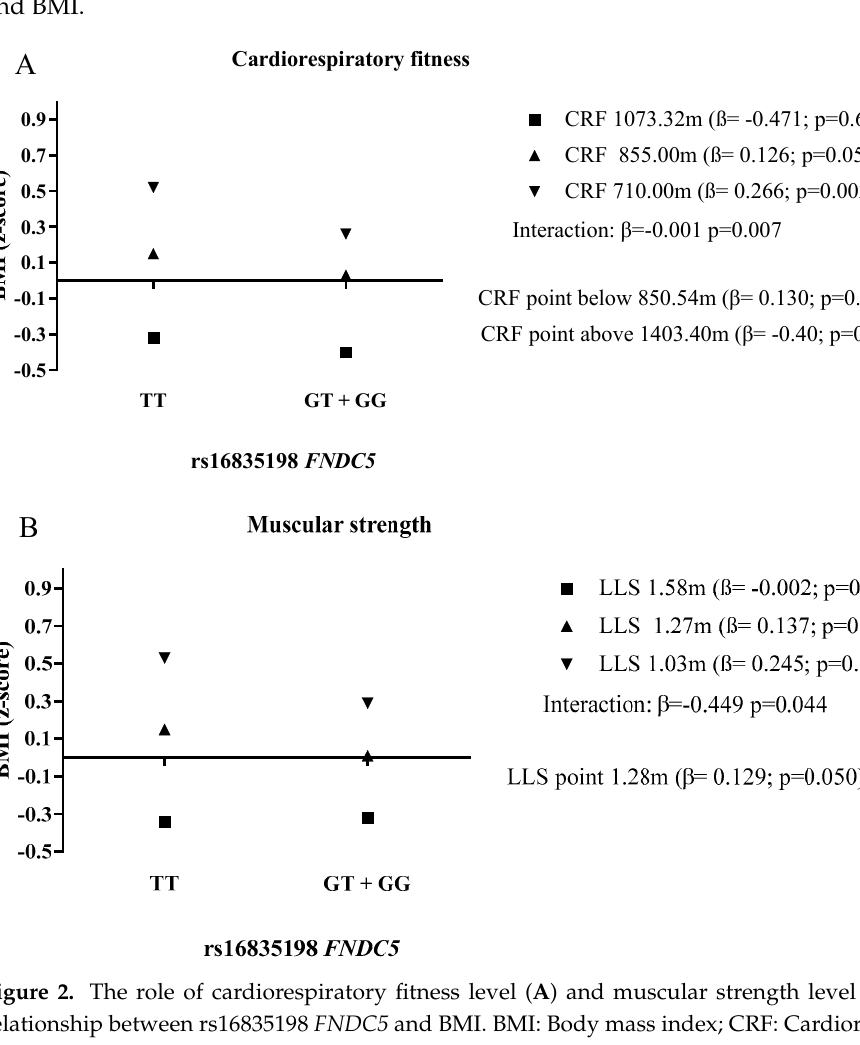
Figure 1. The role of cardiorespiratory fitness level ( A ) and muscular strength level ( B ) in the rela- tionship between rs16835198 FNDC5 and waist circumference. CRF: Cardiorespiratory fitness; LLS: Lower limb strength. All analyses were adjusted for age, sex, skin color, living area, and school network.